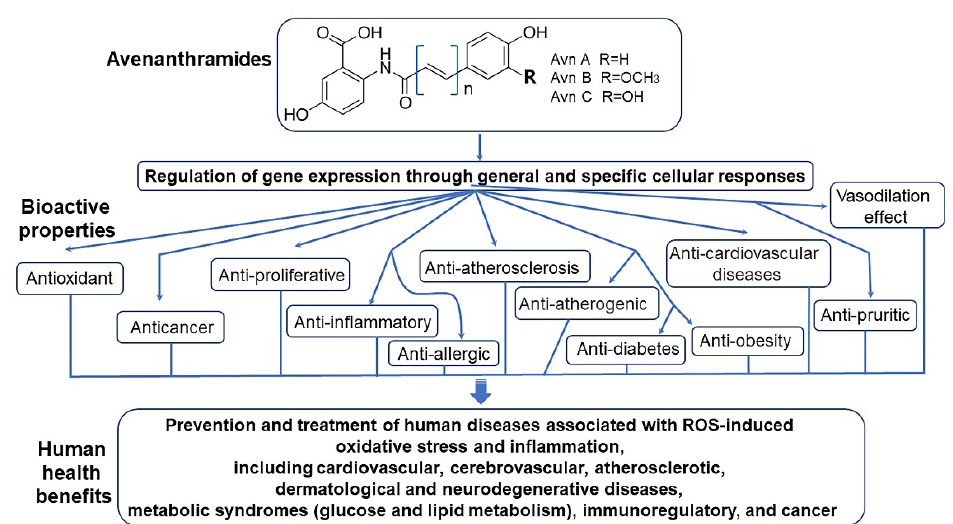
Figure 12. Physiological bioactivities of oat-derived avenanthramides [65,110,120].